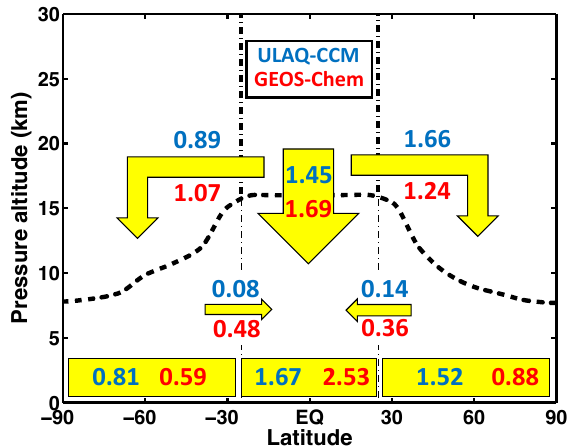
Figure 3. Breakdown of geoengineering sulfur fluxes for ULAQ- CCM (blue – average 2030–2039) and GEOS-Chem (red – average 2000–2005). The dashed line represents the mean tropopause; the dashed–dotted lines represent the subtropical barriers. The lower- most boxes represent sulfur surface deposition. All values are in TgSyr − 1